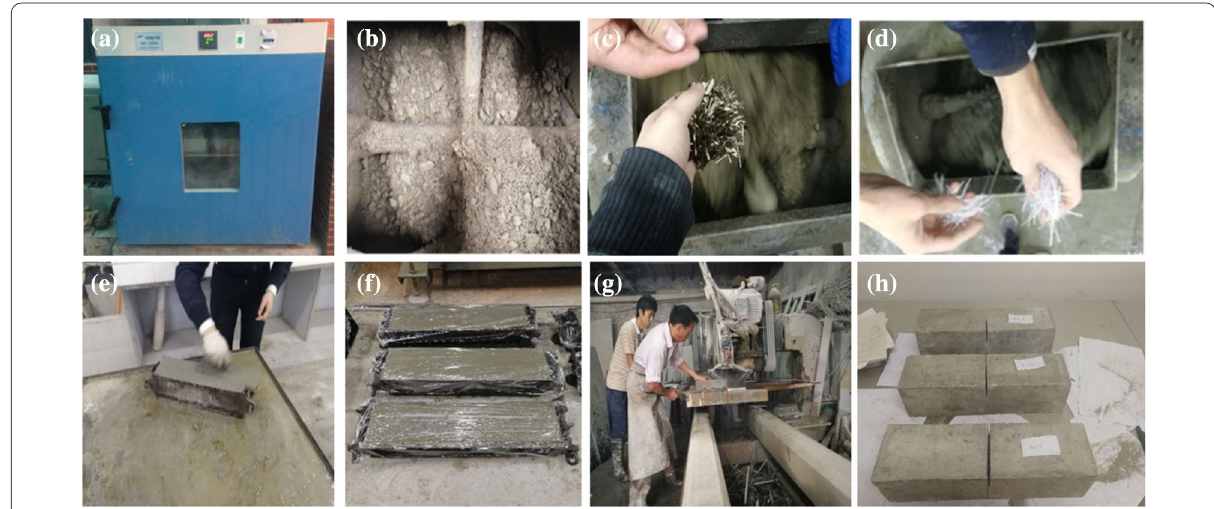
Fig. 4 Partial production procedures of specimens: a aggregate drying; b stir aggregates; c scatter basalt fiber; d scatter polypropylene fiber; e table vibrator; f coating maintenance; g cutting and polishing; and h specimen sample.